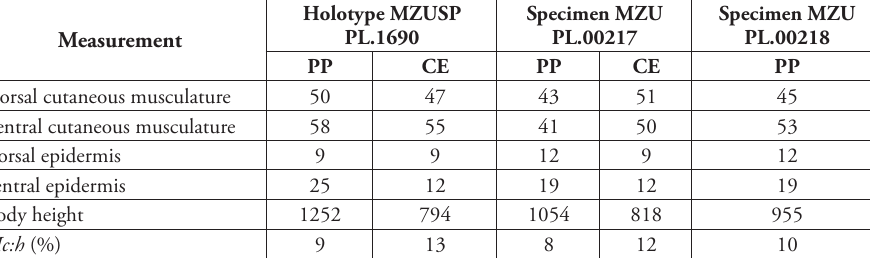
Table 2. Body height and cutaneous musculature in the median region of a transversal section of the pre-pharyngeal (PP) and cephalic (CE) regions, in micrometres, and ratio of the thickness of cutaneous musculature to the height of the body ( mc:h index) of specimens of Cratera cryptolineata sp. n. Holotype MZUSP Measurement